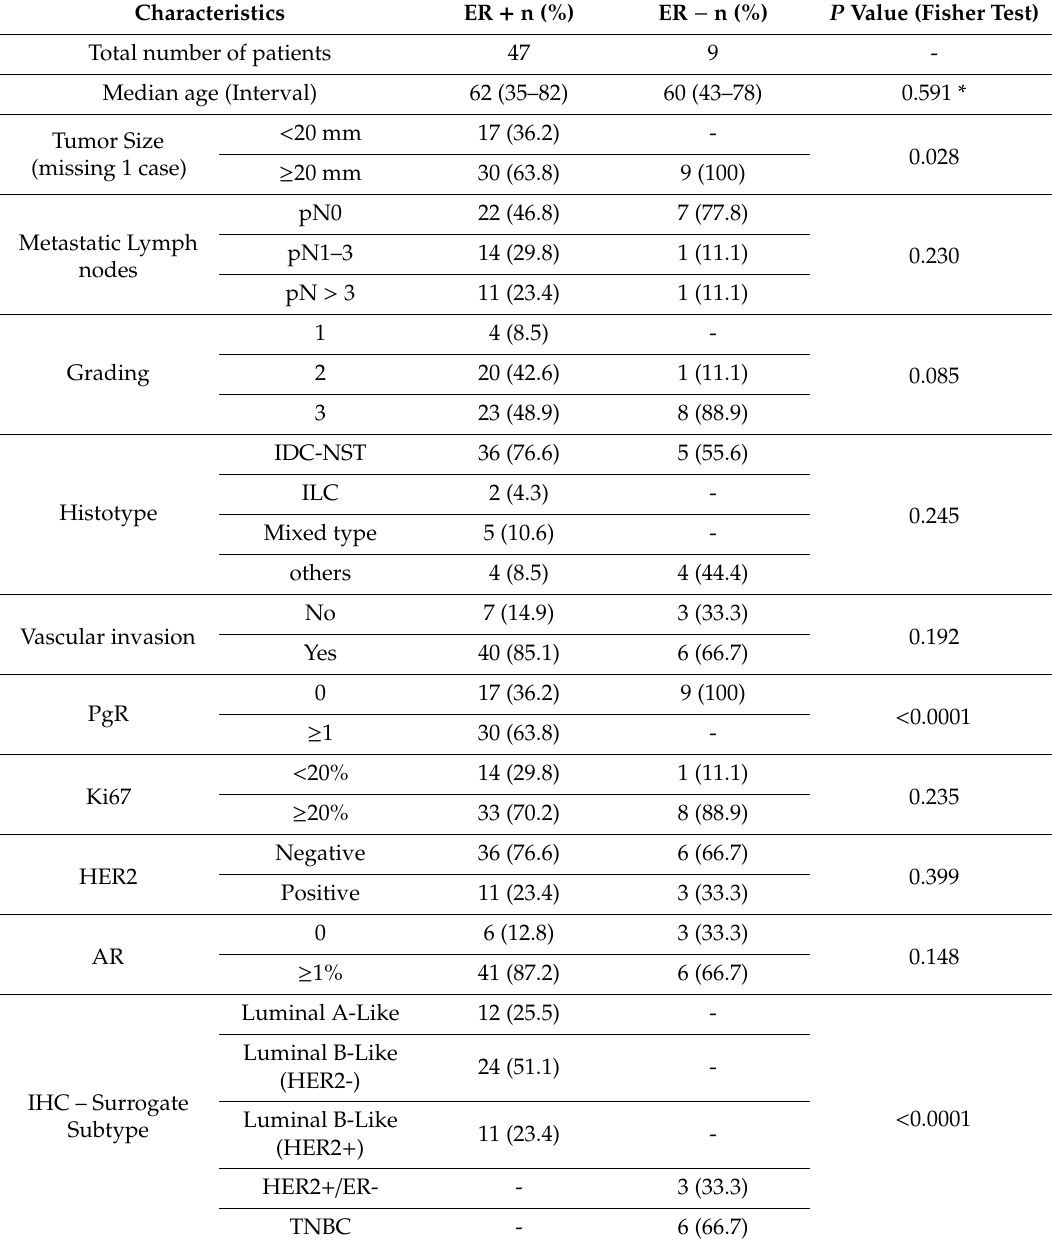
Table 1. Clinical and histopathological characteristics of breast cancer (BC) patients studied. Prognostic marker classification and IHC-surrogate subtype definition were established following St. Gallen and ASCO / CAP guideline